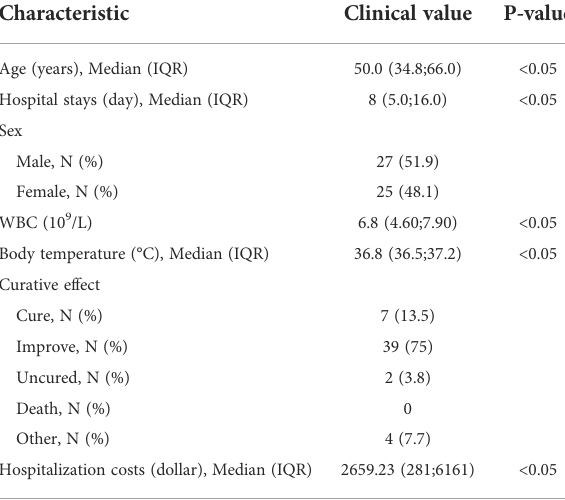
TABLE 2 Sample type. TABLE 1 Baseline characteristics of the study